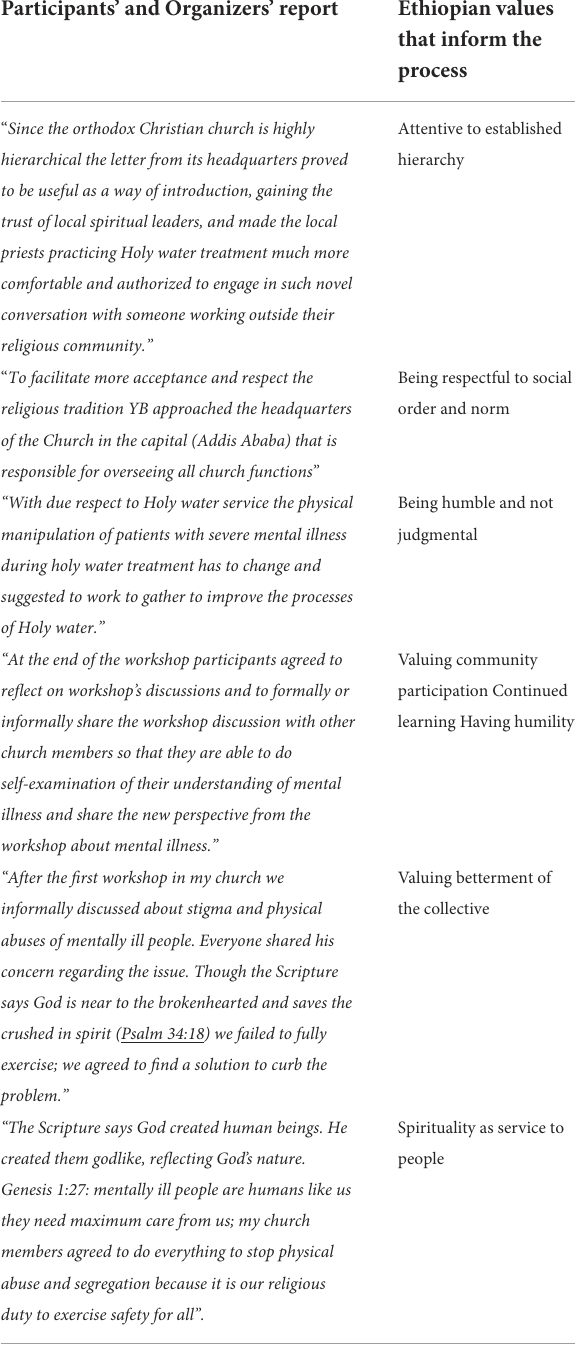
TABLE 2 Cultural adaptations to Mezirow’s Phases of